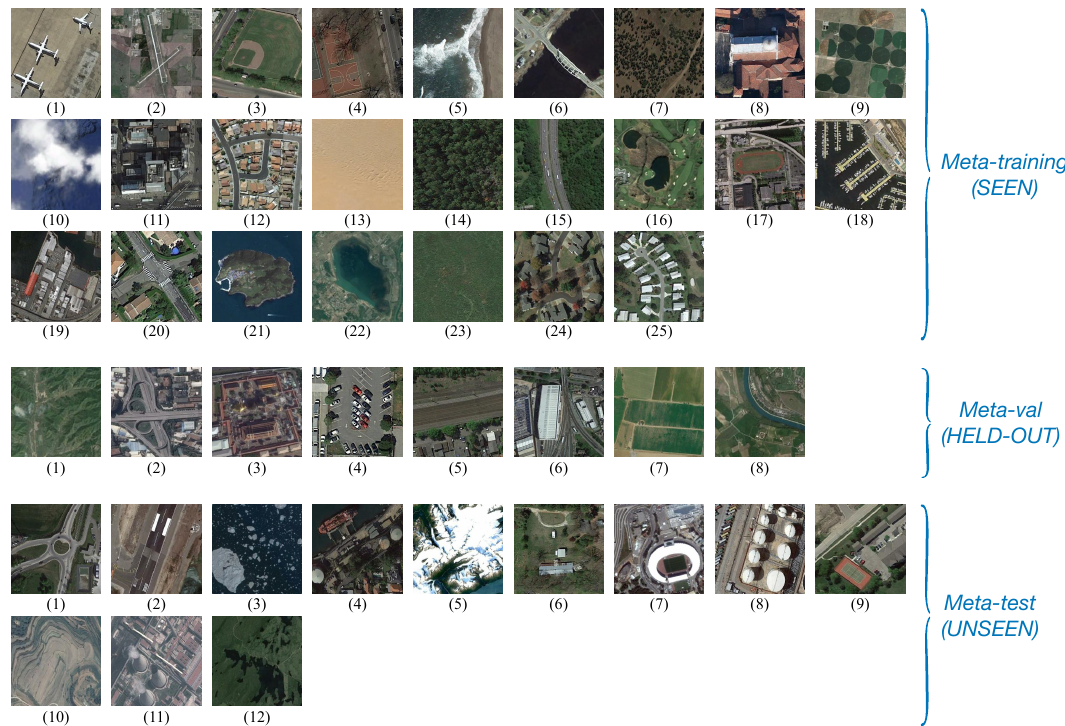
Figure 8. NWPU-RESISC45 Dataset split. Meta-training (SEEN): (1) airplane, (2) airport, (3) baseball diamond, (4) basketball court, (5) beach, (6) bridge, (7) chaparral, (8) church, (9) circular farmland, (10) cloud, (11) commercial area, (12) dense residential, (13) desert, (14) forest, (15) freeway, (16) golf course, (17) ground track field, (18) harbor, (19) industrial area, (20) intersection, (21) island, (22) lake, (23) meadow, (24) medium residential, (25) mobile home park; Meta-validation (HELD-OUT): (1) mountain, (2) overpass, (3) palace, (4) parking lot, (5) railway, (6) railway station, (7) rectangular farmland, (8) river; Meta-test (UNSEEN): (1) roundabout, (2) runway, (3) sea ice, (4) ship, (5) snowberg, (6) sparse residential, (7) stadium, (8) storage tank, (9) tennis court, (10) terrace, (11) thermal power station, (12)